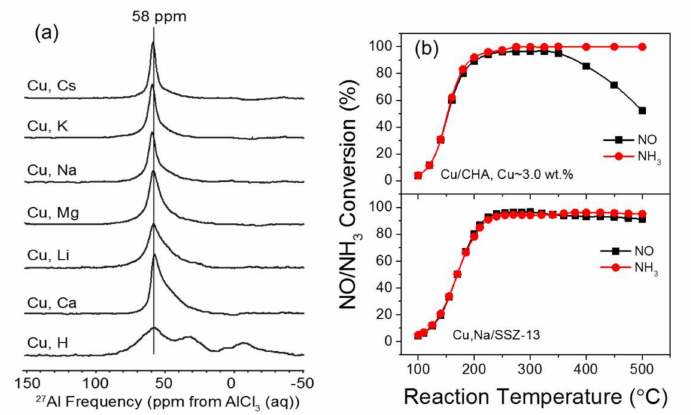
Figure 17. ( a ) 27 Al NMR spectra of hydrothermally aged (HTA) Cu,H and Cu,M/SSZ-13 catalysts, where M represents alkali and alkaline earth coactions; ( b ) NO and NH 3 light-off curves for standard SCR over an HTA Cu/SSZ-13 catalyst with Si/Al = 12.5 and 3.0% Cu and an HTA Cu,Na/SSZ-13 catalyst with Si/Al = 6, 1.0% Cu and 1.8% Na. Adapted with permission from ACS Catal. , 2015 , 5 , 6780–6791. Copyright 2015, American Chemical